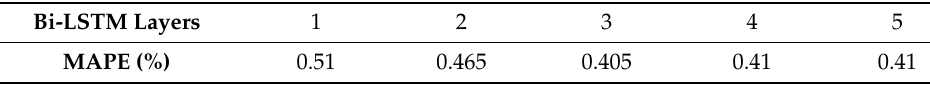
Table 2. Error of different stacked layers of bidirectional LSTM.